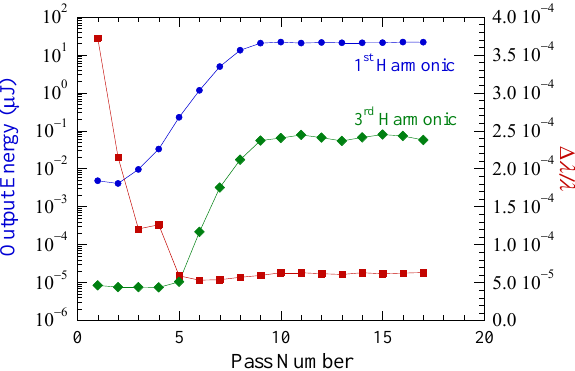
Figure 25. Evolution of the fundamental pulse energy (blue, left) and the 3rd harmonic (green, left), as well as the relative linewidth (red, right) when the cavity detuning is ∆ L cav = 5 µm and for an electron beam energy spread ∆ E b / E b = 1.25 × 10 − 4 . Other parameters as described in the